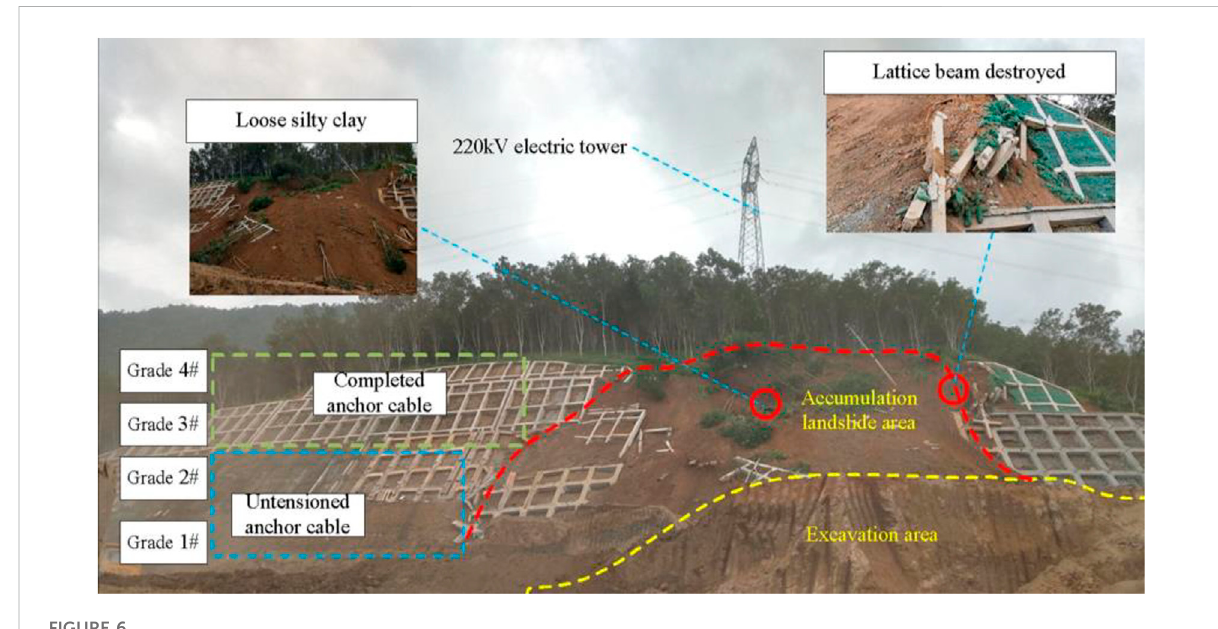
Engineering geologic pro fi le of K26 +